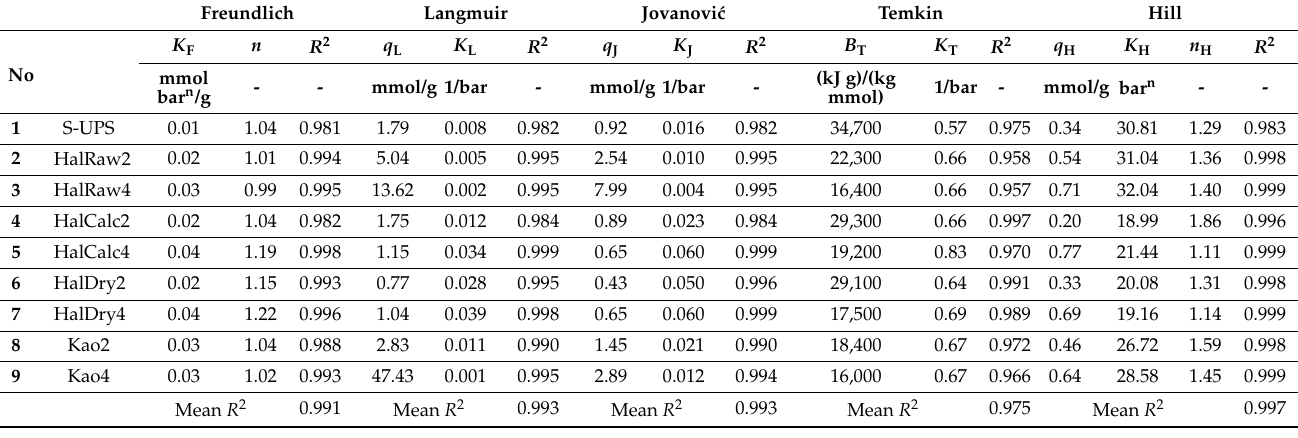
Table 2. The values of adsorption isotherm parameters according to the Freundlich, Langmuir, Jovanovi´c, Temkin, and Hill